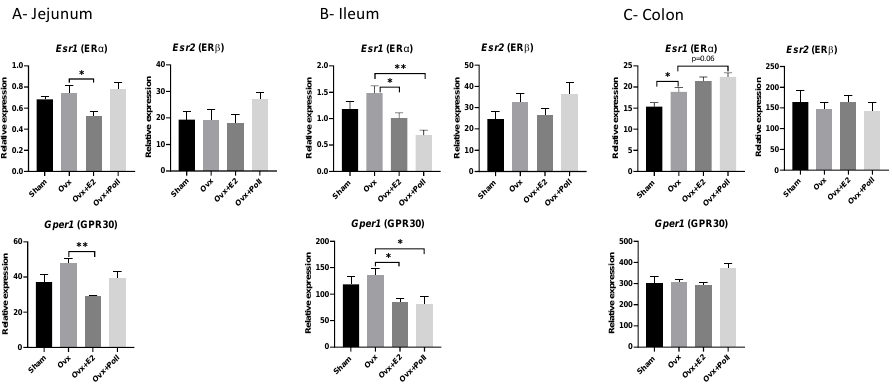
Figure 1. Effect of ovariectomy alone (Ovx) or with 17 β -estradiol (E2) supplementation (Ovx+E2) or with exposure to pollutants (Ovx + Poll) on the expression of genes encoding the estrogen receptors ER α , ER β , GPR30 in various segments of the gut: The jejunum ( A ), the ileum ( B ), and the colon ( C ). Values are means ± SEM with n = 6–8. ** p < 0.01; * p < 0.05. Sham: Sham-operated mice.